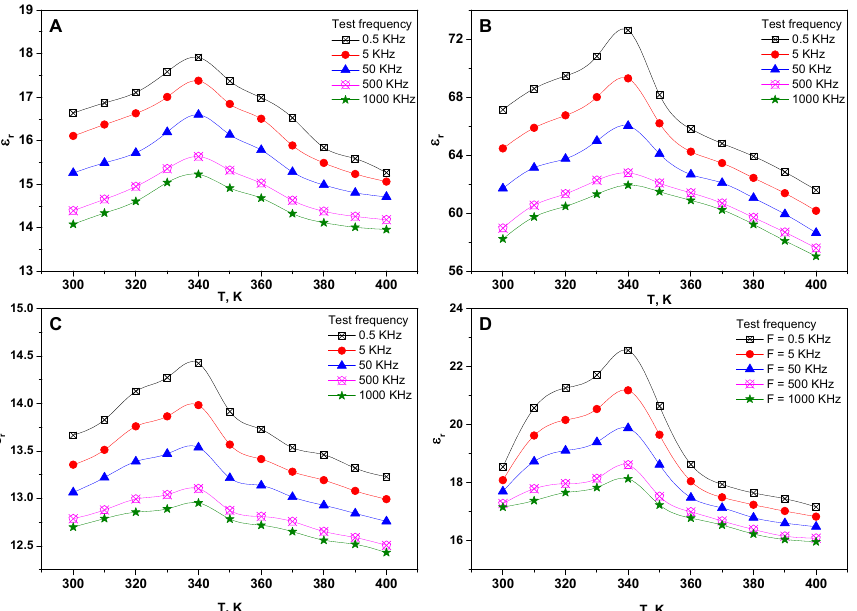
Figure 2 . Temperature and frequency dependence on real dielectric constant for ( A ) poly(EDMA), ( B ) Pd(OAc) 2 /poly(EDMA)-5.1%, ( C ) poly(EDMA-co-MMA), and ( D ) Pd(OAc) 2 /poly(EDMA-co- MMA)-1.6%.